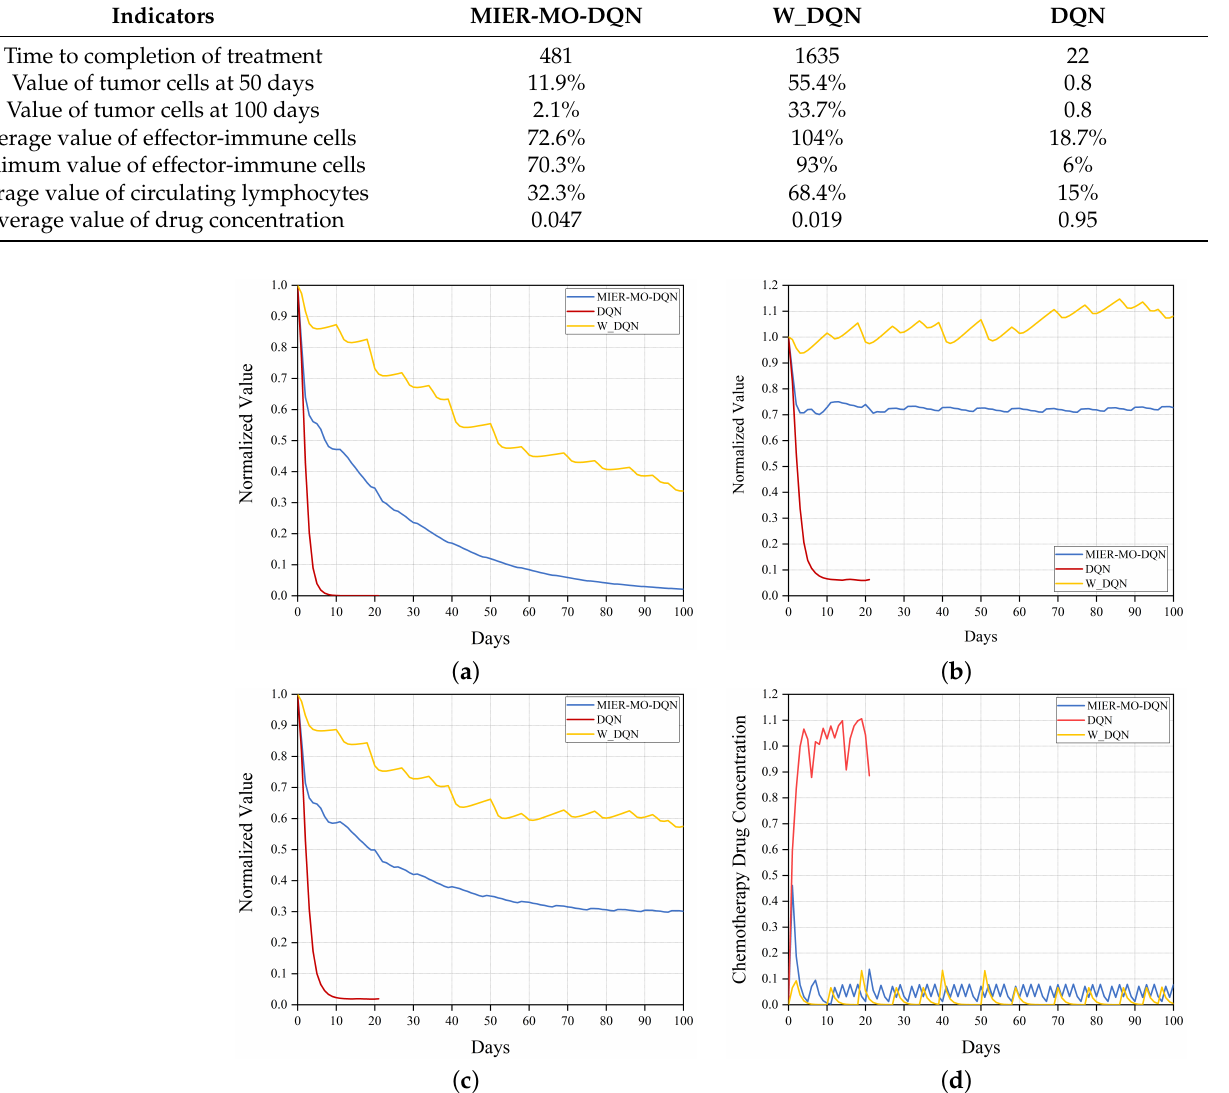
Figure 9. The change of ( a ) tumor cells, ( b ) effector-immune cells, ( c ) circulating lymphocytes, ( d ) drug concentration, according to different methods in Scenario